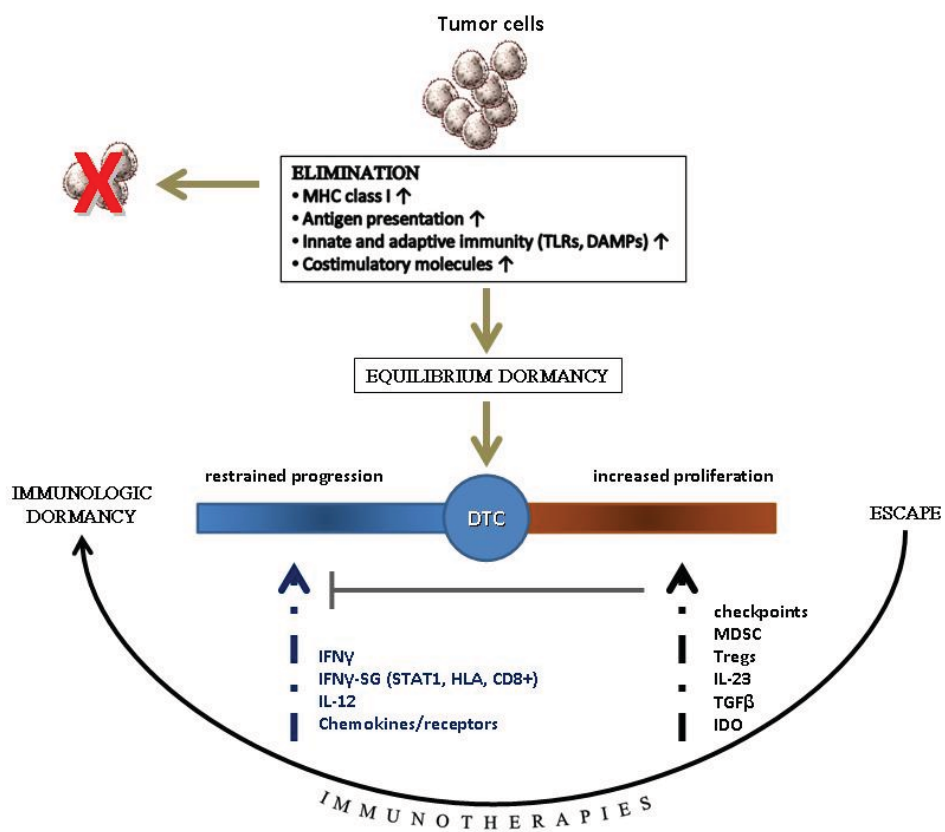
Figure 2. Control of DTC via the immune system: In early tumor development immunogenic tumor clones are recognized and eliminated by both innate and adaptive immune-mediated mechanisms (elimination). In the equilibrium dormancy, the “edited” tumor cells and the adaptive immune system coexist: tumor growth rates are controlled by an active Th1 adaptive immunity. Tumor escape occurs by immunosuppressive cytokines and enzymes, Tregs, MDSCs, and activation of immune checkpoints. Immunotherapies aim to shift the balance from escape to equilibrium dormancy. TLRs: toll-like receptors; DAMPs: danger-associated molecular pattern molecules; IFN(cid:3)-SG: IFN(cid:3)-stimulated genes; STAT1: signal transducers and activator of transcription 1; TGF(cid:2): transforming growth factor beta; IDO: Indoleamine